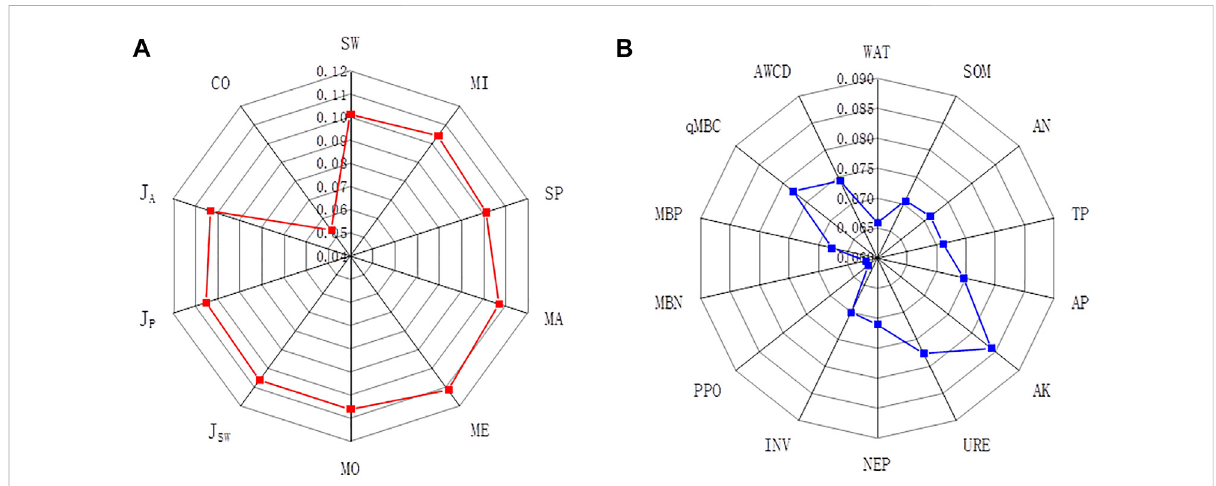
FIGURE 1 Radar map of coupling coordination index and weight between vegetation system (A) and soil system (B)